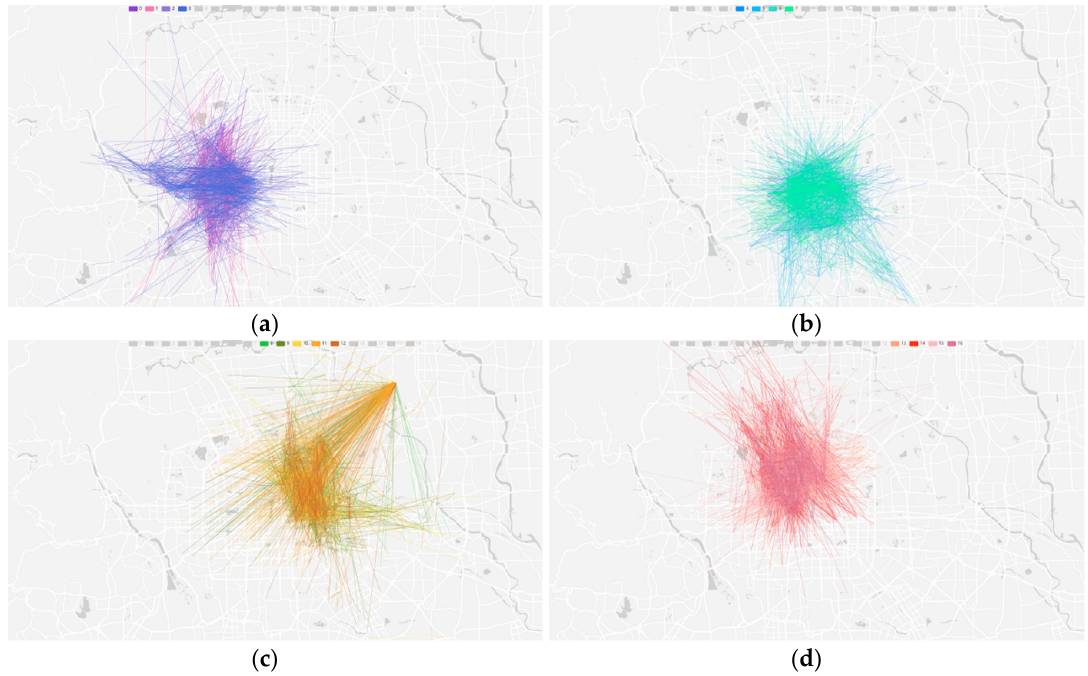
Figure 9. Four taxi OD flow spatial clusters and communities based on OD flow event point clustering process. Spatial clusters ( a ), ( b ) and ( d ) contain four vector clusters respectively, and spatial cluster ( c ) contains five vector clusters.